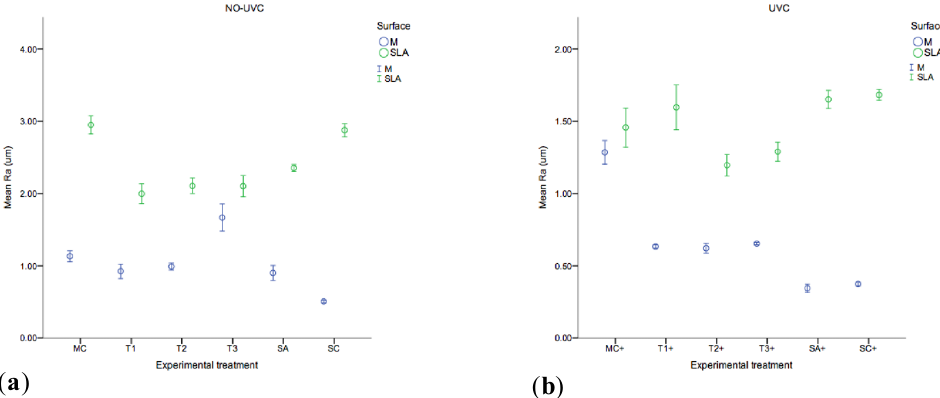
Figure 2. Surface roughness values of Machined and SLA topographies across ( a ) control (MC, SA, SC) and ( b ) experimental (T1, T2, T3) protocols − /+ UVC irradiation ( n = 3). Each circle represents the mean and error bars the 95% CI.